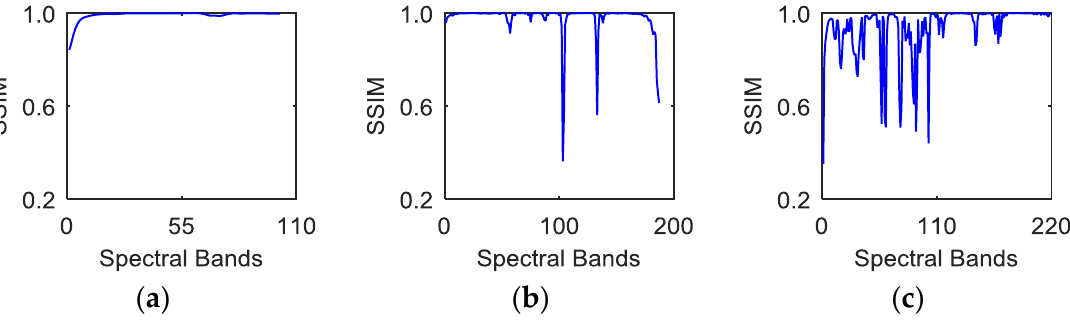
Figure 2. Structural correlation curves of different hyperspectral images: ( a ) Pavia data; ( b ) Urban data. ( c ) Indian Pines data.